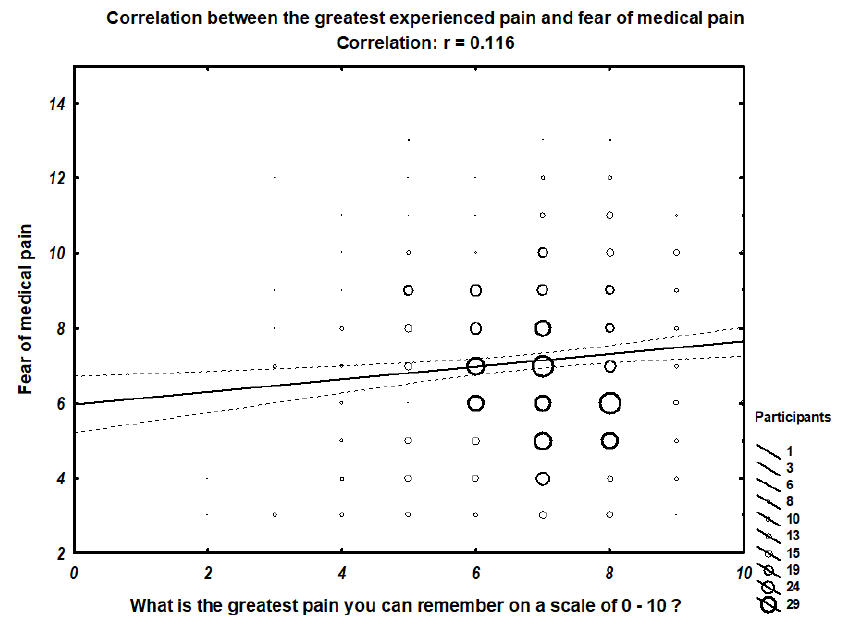
Figure 2. Correlation between the greatest experienced pain and fear of medical pain.